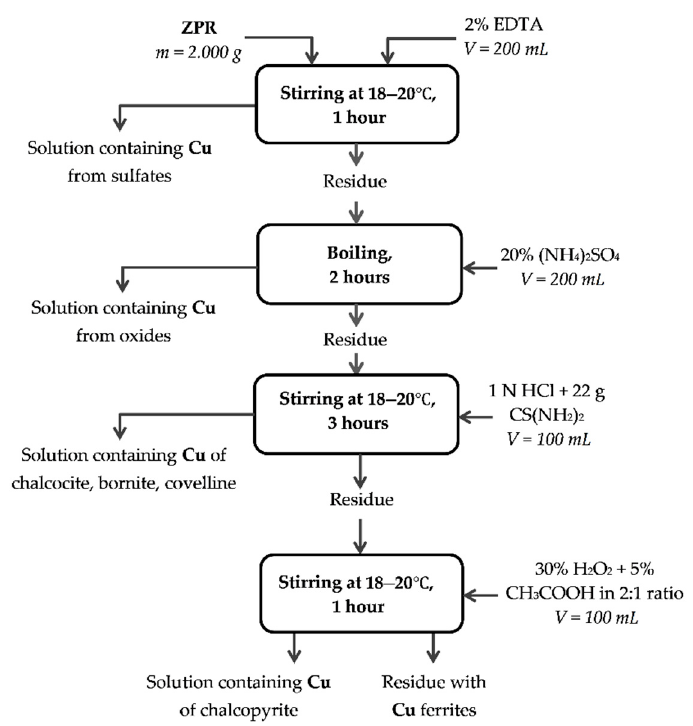
Figure A4. Method of chemical phase analysis of copper compounds.